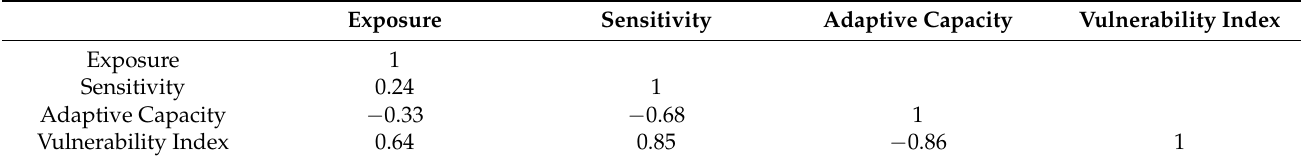
Table 7. Correlation between subindices and the COVID-19 Vulnerability Index.